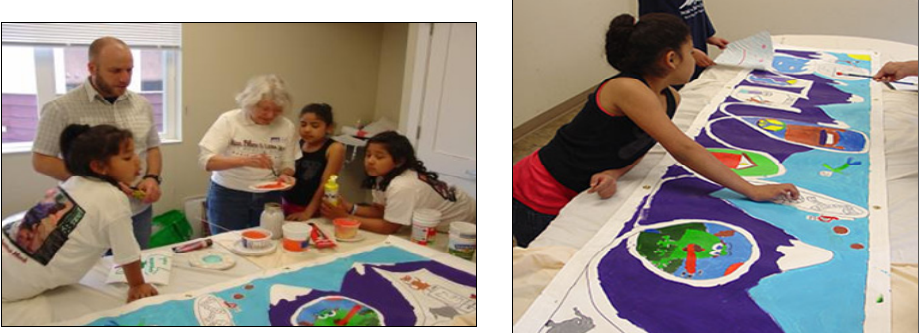
Figure 1. “Dreamers” and the facilitating artist painting a banner in the after school program at Manhattan Middle School (photo courtesy of